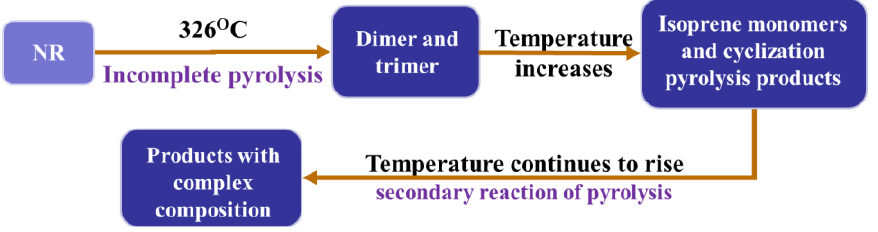
Figure 4. The pyrolysis process of NR.